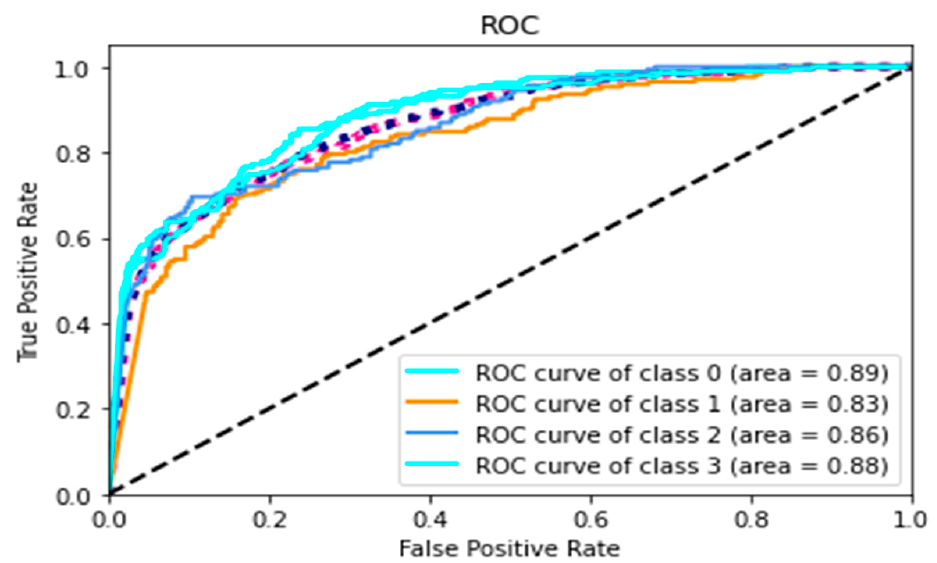
Figure 11. The ROC curve for multi-class classification using DeepBiLSTM. (Pink squares represent micro-average ROC curve, while purple squares represent the macro-average ROC curve).